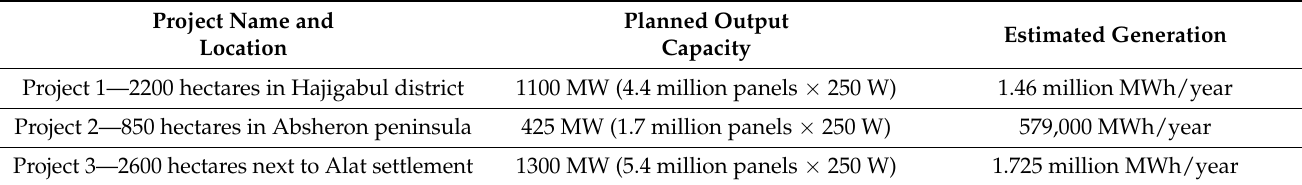
Figure 7. Direct Normal Irradiation map of Azerbaijan [26]. Table 9. Prospective solar plant projects presented by the Ministry of Energy of Azerbaijan [27].